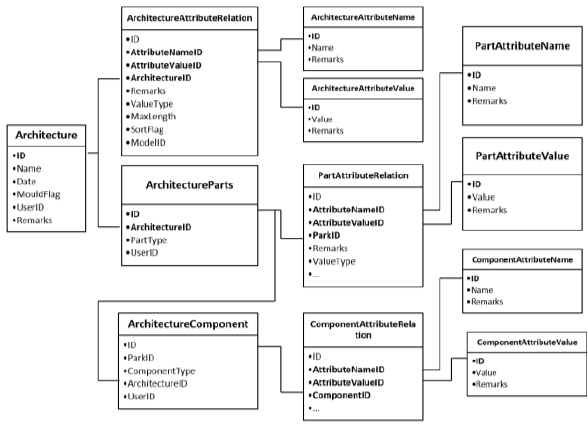
Figure 9. Logical Structure of a